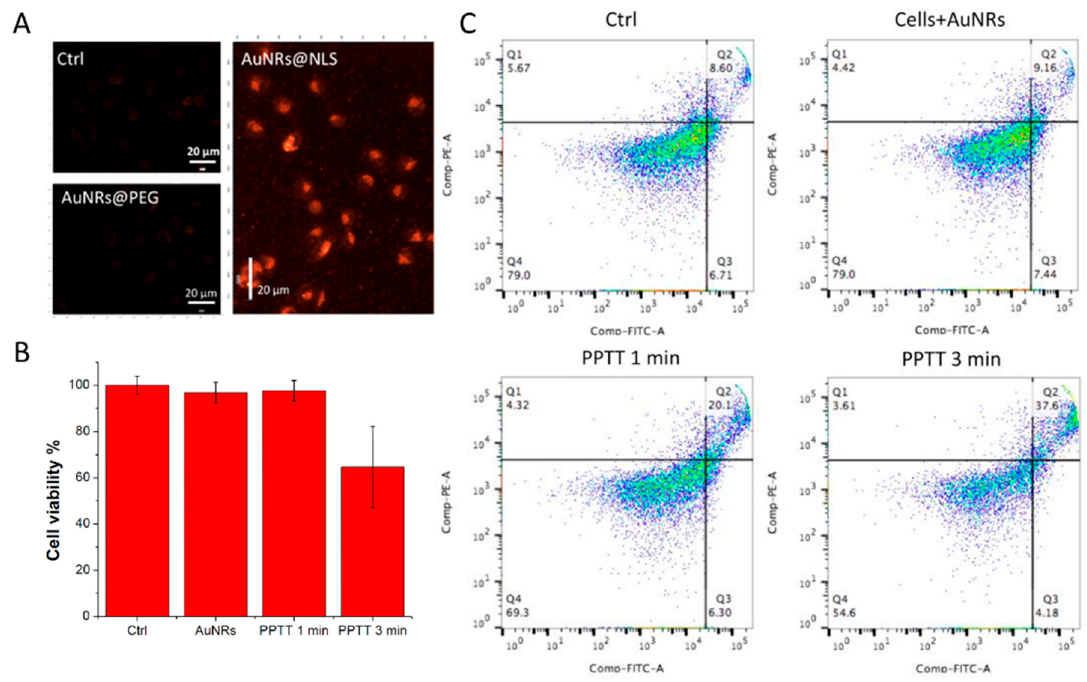
Figure 9. ( A ) Dark-field images of pure HSC-3 cells, cell incubated AuNRs@PEG, and cells incubated in AuNRs@NLS for 24 h. Scale bar = 20 µ m; cell viability ( B ) and apoptosis/necrosis assay ( C ) for the HSC-3 cells treated with PPTT at different times; Q1 (necrosis), Q2 (apoptosis), Q3 (early apoptosis) and Q4 (early apoptosis) [86].